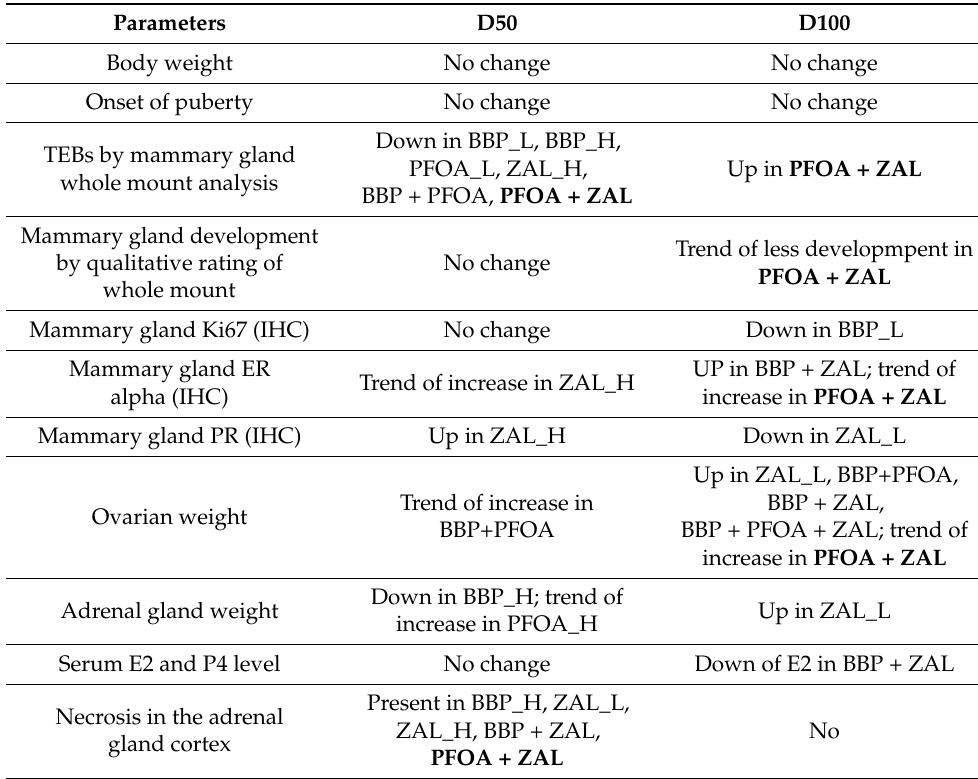
Table 1. Summary of phenotypic changes induced by exposure to the